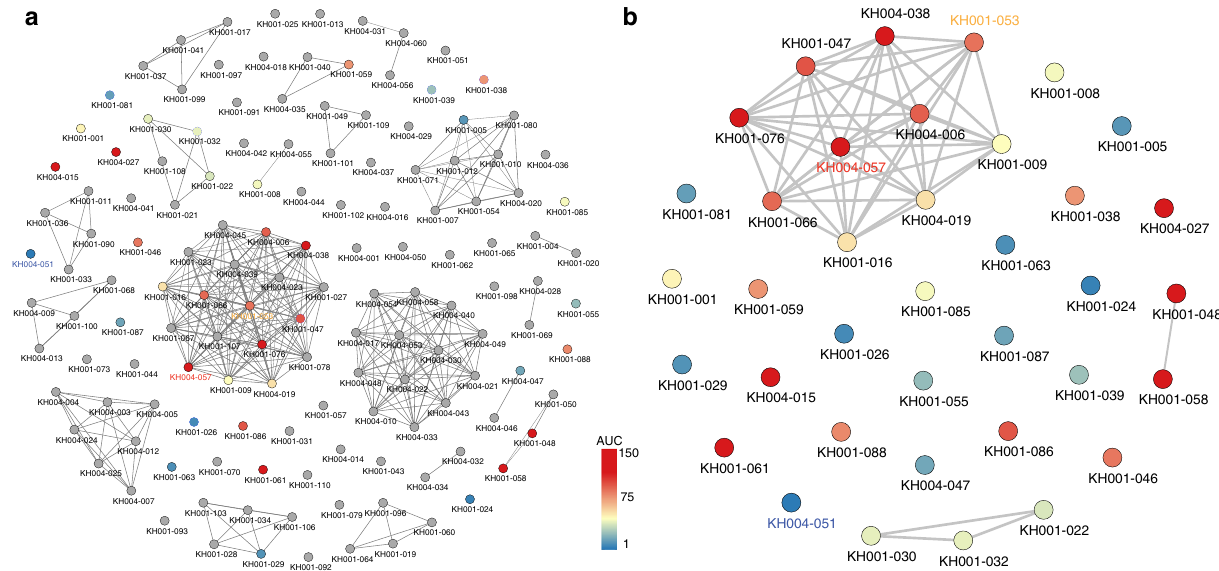
Fig. 2 PPQR parasites detected within both highly related and unrelated parasite populations. Identity By Descent (IBD) analysis was performed on 157 parasite isolates and a gray line connects parasites sharing> 90% of their genome sequences a . Parasites that were phenotyped for PPQ resistance are shown in color, and those not tested are shown in gray. PPQR and PPQS parasites are shown in red and blue, respectively, with the scale of AUC shown. A representative PPQS parasite (KH004_051) is labeled blue, an intermediate PPQR parasite (KH001_053) orange, and a highly-PPQR parasite (KH004_057) red. a shows all 157 parasites genotyped, and b shows all the phenotyped parasites from